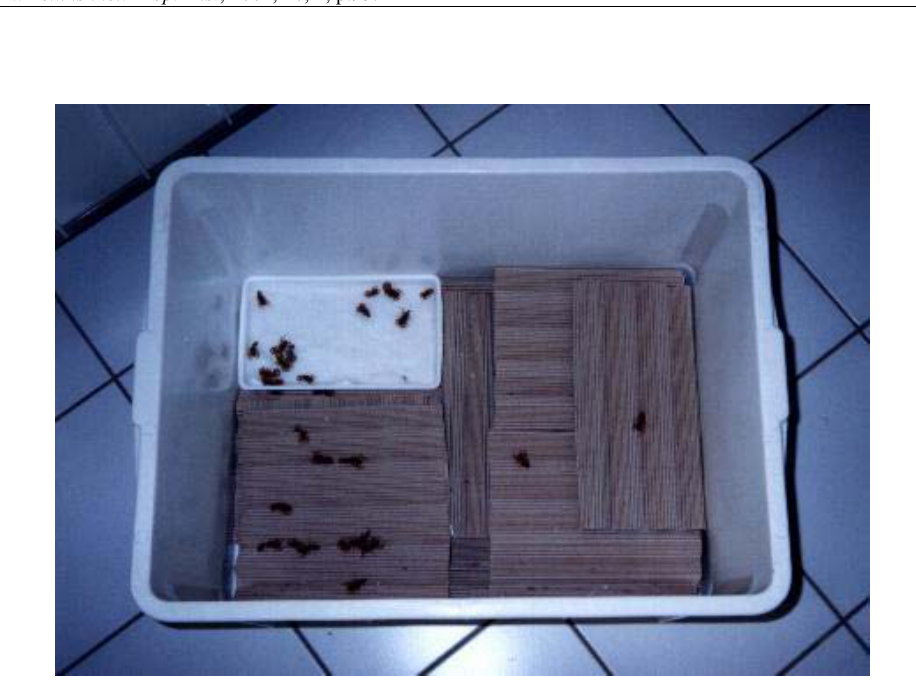
Figure 2. The scorpion’s box. D. M. Candido.